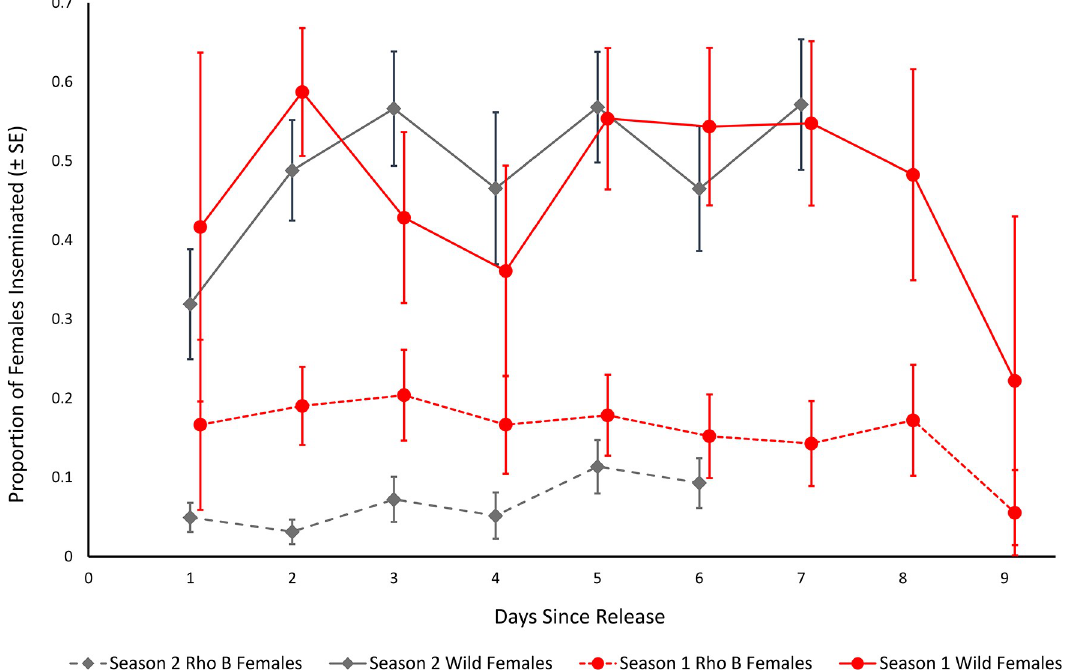
Fig 3. Mean daily proportion (SE) of captured Aedes aegypti females inseminated by wild or rhodamine B marked males. Differences between time of year are indicated by early summer (season 1, red circles) and late summer (season 2, grey diamonds).